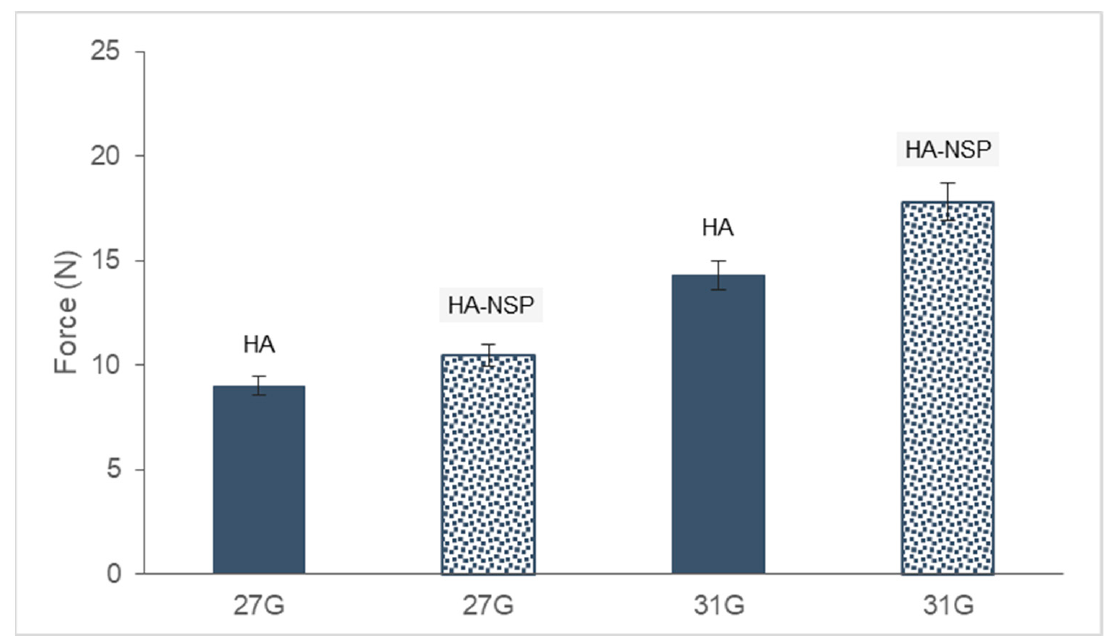
Figure 14. Maximum injection force for 1% HA gel and HA-NSP using two needle sizes.